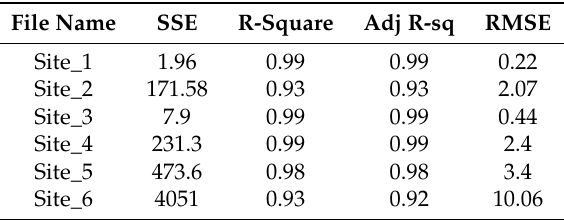
Table 2. Summary of the curve fitting